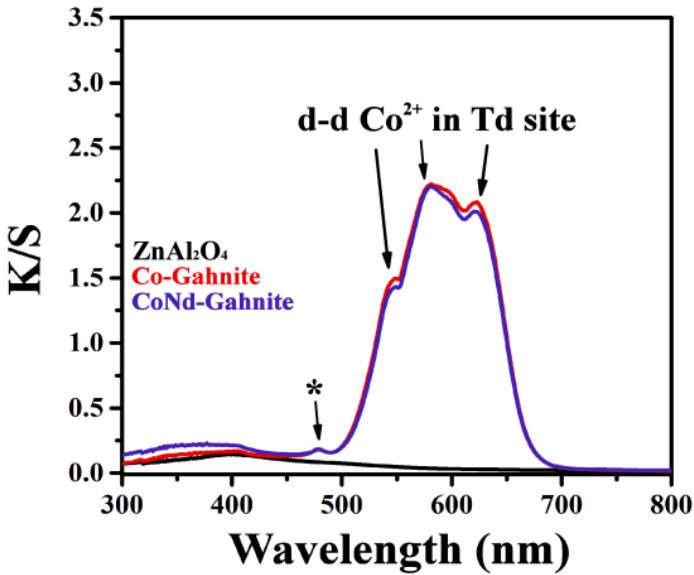
Figure 5. K/S absorption spectra of ZnAl 2 O 4 :M (M = Co 2+ and Co 2+ /Nd 3+ ) pigments, calcined at 1000 °C.